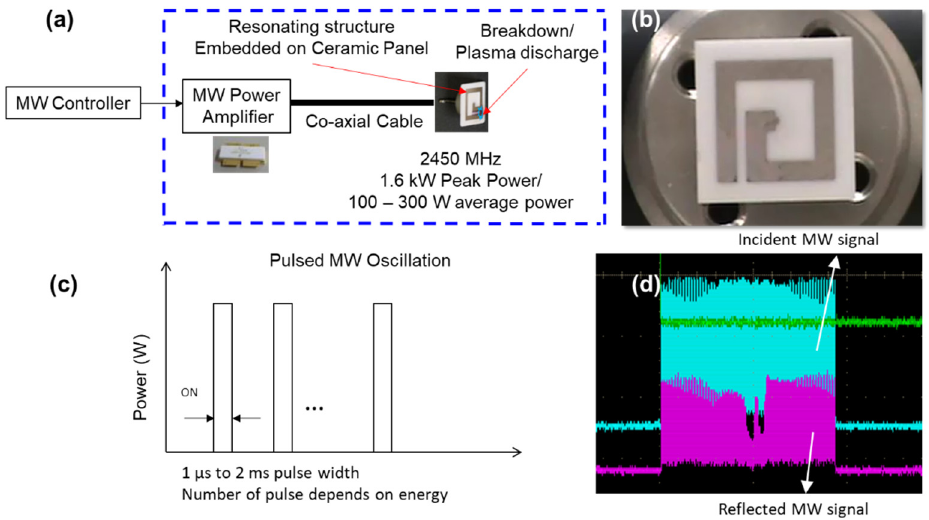
Figure 14. Flat panel igniter (FPI) ( a ) schematic operation, ( b ) actual image, ( c ) schematic oscillation pattern, ( d ) actual oscillation pattern.